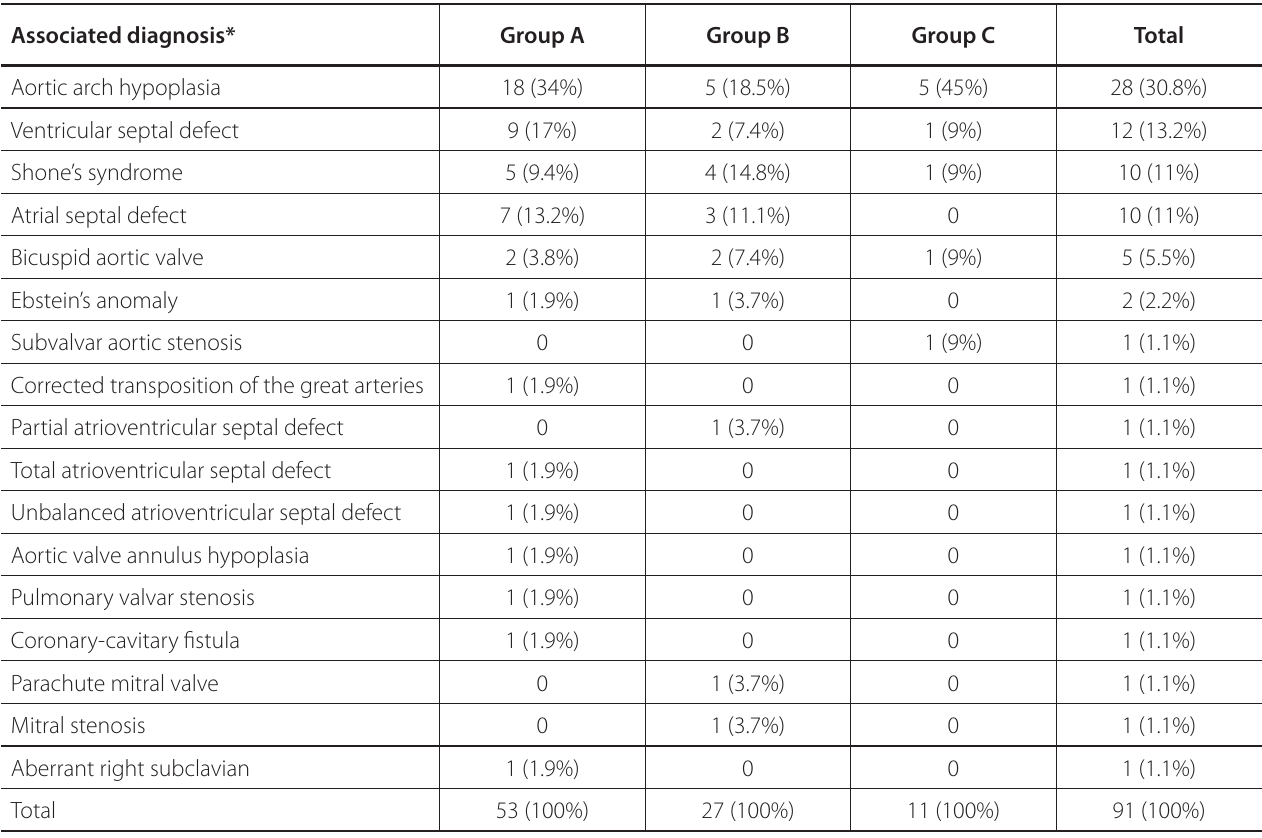
Table 2 . Main preoperative diagnosis of cardiac lesions associated to coarctation of the aorta. Associated diagnosis*